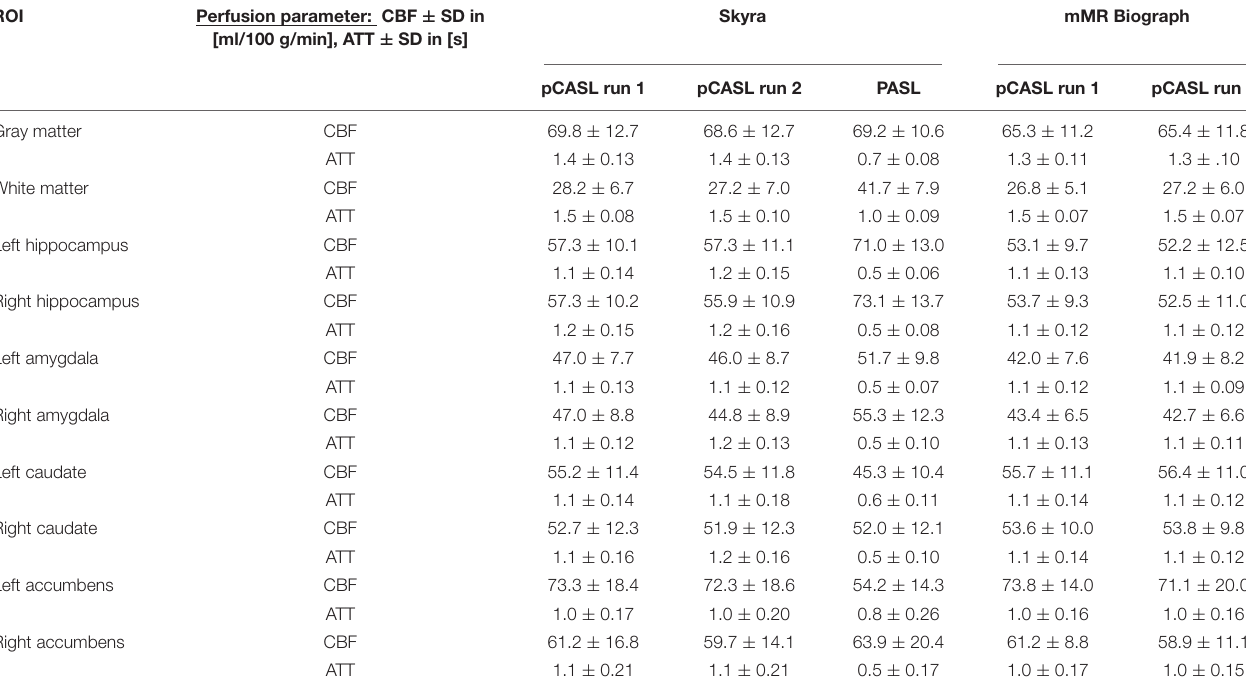
FIGURE 1 | Visualization of the arterial spin labeling (ASL) bolus passage through the gray matter region-of-interest: The mean ASL difference signal at each measured or decoded time point is plotted separately for every participant. The mean of all lines is shown with a bold red line. In pseudo-continuous ASL (pCASL) acquisitions at the Skyra (A) and mMR Biograph (B) a compensation of the T1 related signal decay was applied. This is shown by an almost horizontal line of the mean ASL difference signal at later time points, opposite to the signal decrease in pulsed ASL (PASL) acquisitions at the Skyra (C) , where this method was not used. The mean ASL difference signal was scaled by dividing all values of each individual curve by its maximum. TABLE 1 | Mean cerebral blood flow (CBF) and arterial transit time (ATT) for several region-of-interests (ROI) for pseudo-continuous ASL (pCASL) and pulsed ASL (PASL) acquisitions at 3T Siemens magnetic resonance imaging (MRI) systems (Skyra and mMR